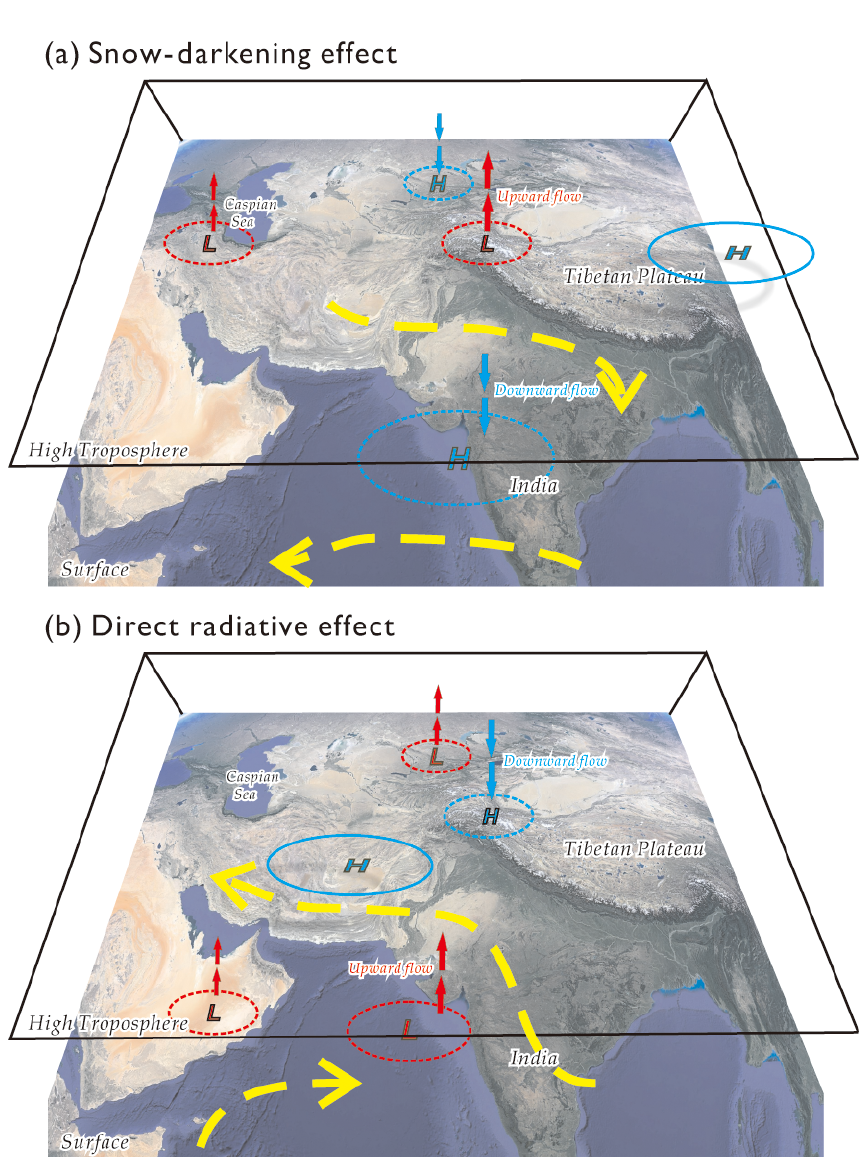
Figure 14. Schematic diagrams showing the forcing mechanisms of the snow-darkening effect (a) and direct radiative effect (b) of mineral dust on the Indian monsoon during the onset. The circles and abbreviations in them denote the anomalous pressure centers: high pressure (blue), low pressure (red), near surface (dashed) and high troposphere (solid). The red and blue arrows indicate the upward and downward air flows, respectively, and the yellow ones present the differences in horizontal